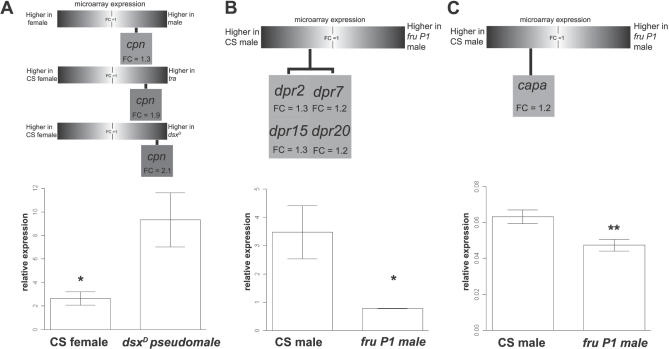
Independent Validation of Microarray Expression Results using RT-PCRFold-change (FC) from averaged microarray data for each validated gene is shown at the top of each panel. Each genotype of the target pair compared in the microarray experiment is indicated at either side of the gradient bar. White in the gradient bar represents no difference in gene expression between the two genotypes (FC = 1), and the white to black gradient indicates increasingly higher expression differences in the genotypes indicated. The FC in gene expression between the two genotypes is shown below the gradient bar in the gray-scaled box. At the bottom of each panel are the results of RT-PCR analysis, for which the expression of a given gene relative to rp49 ribosomal expression is reported. Microarray and RT-PCR results for (A) cpn, (B) dpr-family members, and (C) capa. (A) RT-PCR showed that cpn expression relative to rp49 expression was significantly higher (p < 0.015, 3.5-fold) in dsxD female (mean = 9.32, SE = 1.99) than in CS female (mean = 2.64, SE = 0.49) adult heads.(B) dpr2, dpr7, dpr14, and dpr20 microarray expression, with higher expression in males than fru P1 males. dpr RT-PCR expression relative to rp49 expression was significantly higher (p < 0.05, 4.4-fold) in CS male (mean = 3.47, SE = 0.94) than fru P1 male (mean = 0.78, SE = 0.004) adult heads.(C) RT-PCR showed that capa expression relative to rp49 expression was significantly higher (p < 9.2E-4, 1.4-fold) in CS male (mean = 0.063, SE = 0.003) than fru P1 male-dissected (mean = 0.047, SE = 0.003) CNS tissue. Error bars represent SE. One-tailed t-test: *, p < 0.05; **, p < 0.001.doi:0.1371/journal.pgen.0030216.g004